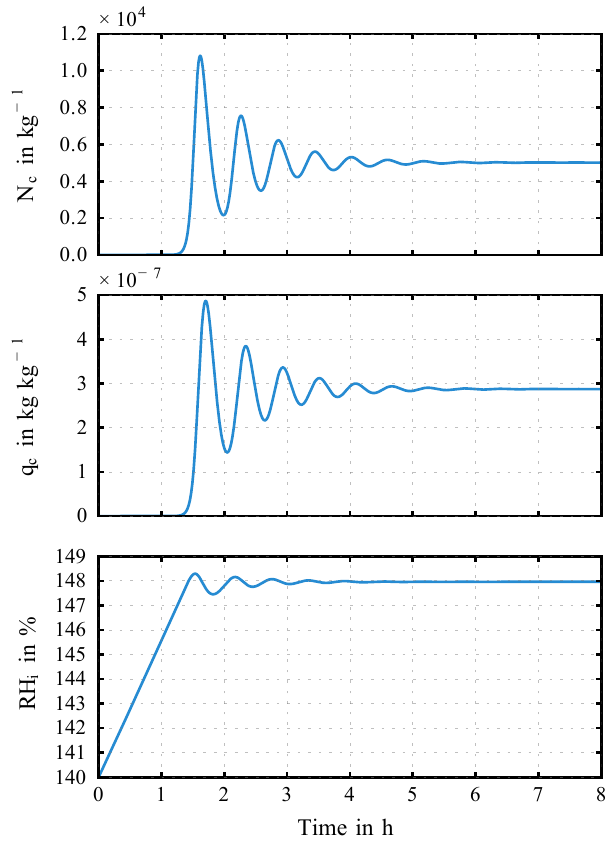
Figure 1. A scenario in state 1 (stable focus regime, damped oscilla- tion) at w = 0 . 01ms − 1 and T = 220K. The continuous nucleation as well as similar timescales of nucleation, growth and sedimen- tation leads to a damped oscillation with an equilibrium state for t > 7h. In phase space, the asymptotic stability is more obvious (see Fig.